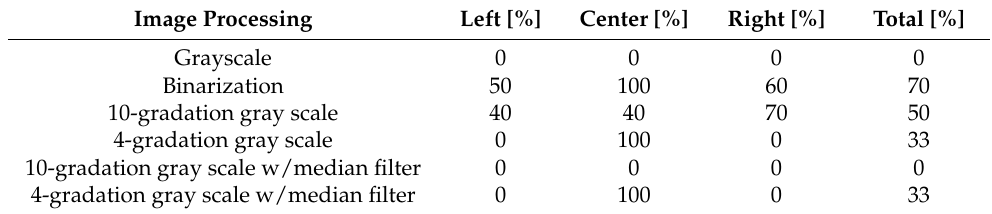
Table 7. Experimental results in real space.